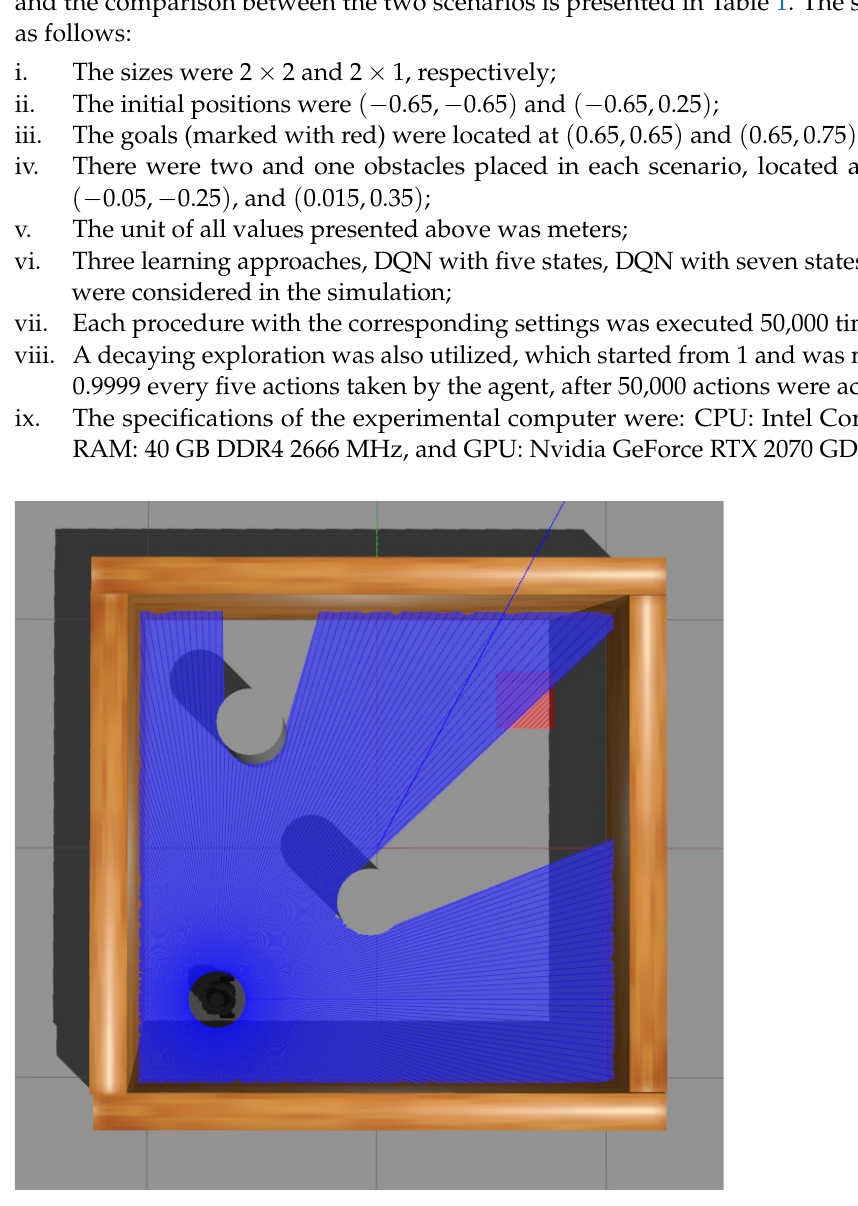
Figure 3. The first experimental scenario with larger size and two